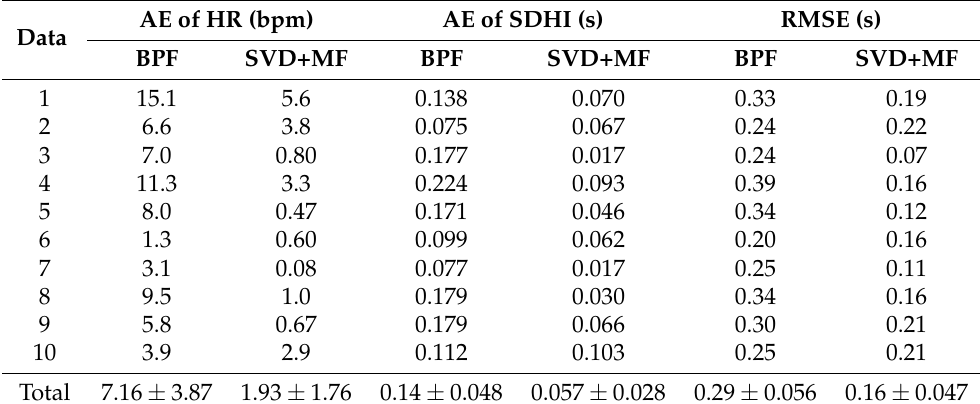
Table 3. Comparison of heart rate estimation accuracy using bandpass filter on signals obtained from subjects in lying position.